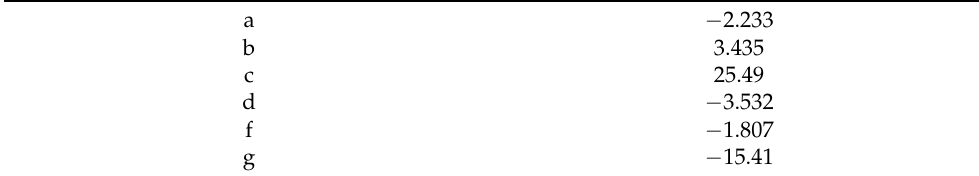
Table 10. Coefficients for the fitting fuction of the female